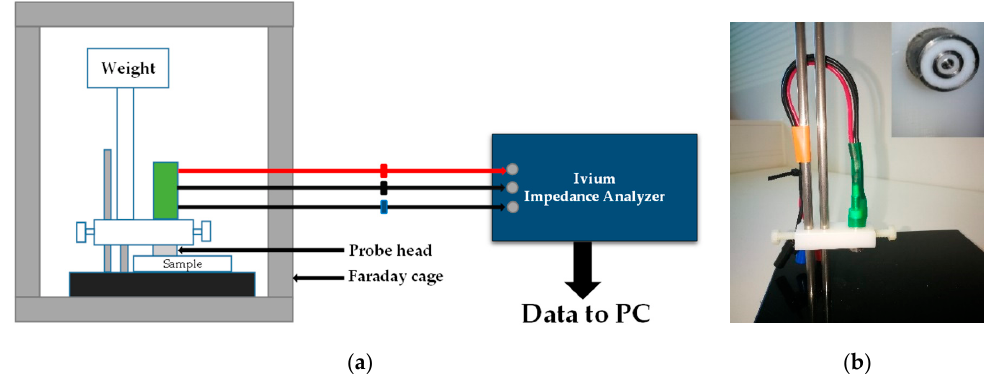
Figure 2. ( a ) Schematic overview of the experimental setup; ( b ) custom-made concentric ring probe with the surface of the probe head shown in the upper right corner of the picture.